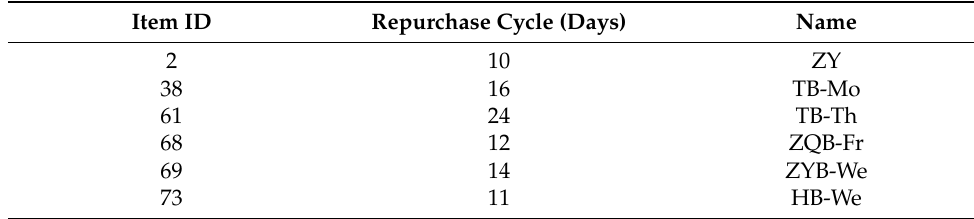
Table 3. Repurchase cycle of typical items included in I A | U B